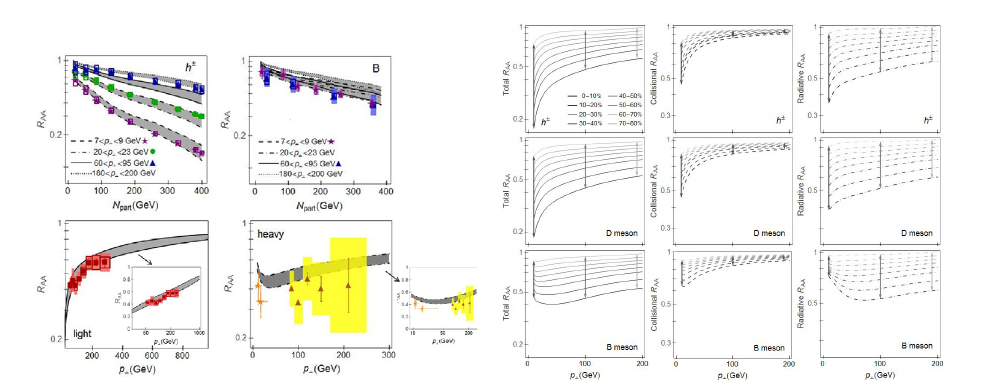
Figure 1. Comparison of suppression patterns data and predictions (gray bands) for light (left column) and B-probes (right column). For exper- imental data see [4]. Figure adapted from [4].